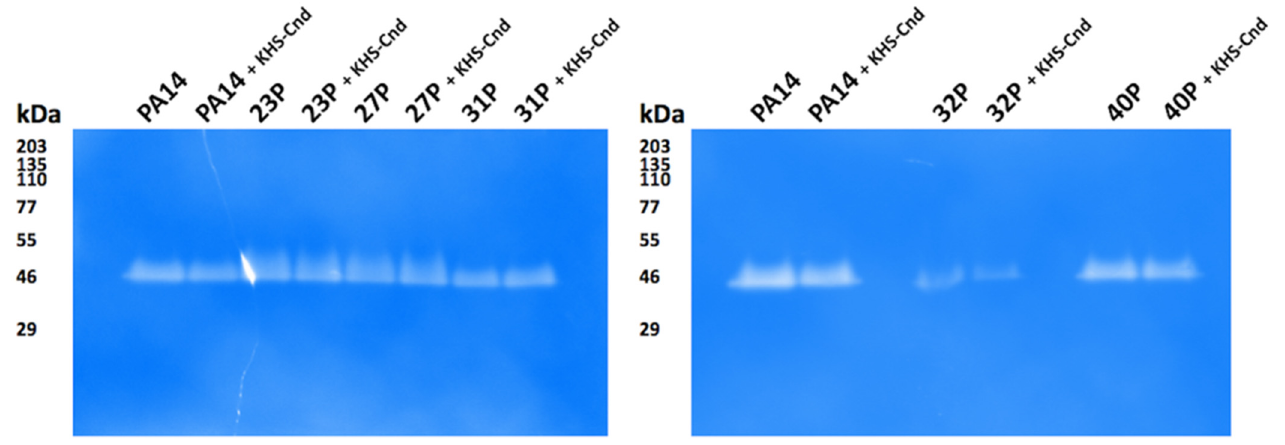
Figure 7. Gelatin-zymography to detect proteases secreted by clinical isolates of P. aeruginosa . Sam- ples of unconcentrated culture supernatants were subjected to SDS-PAGE using 10% gels containing 0.2% gelatin. After gel incubation in renaturation buffer and Coomassie staining, clear bands in the zymograms corresponded to active proteases. The apparent molecular masses of protein standards are indicated in kDa.